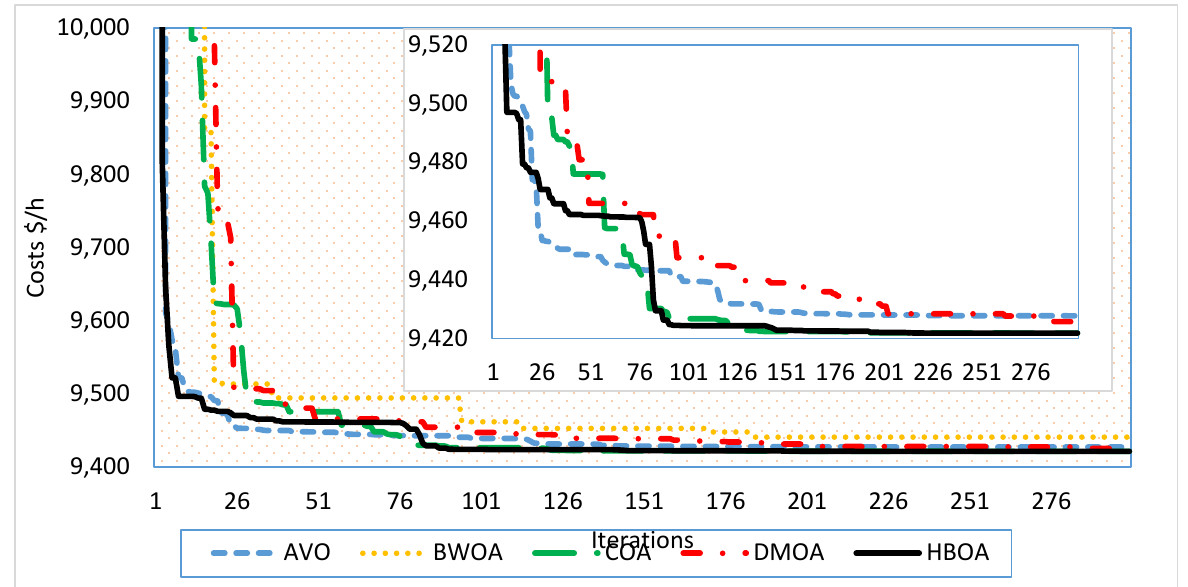
Figure 7. Convergence rates of the proposed HBOA and the AVO, DMOA, COA, and BWOA of Case 2 for the second loading.